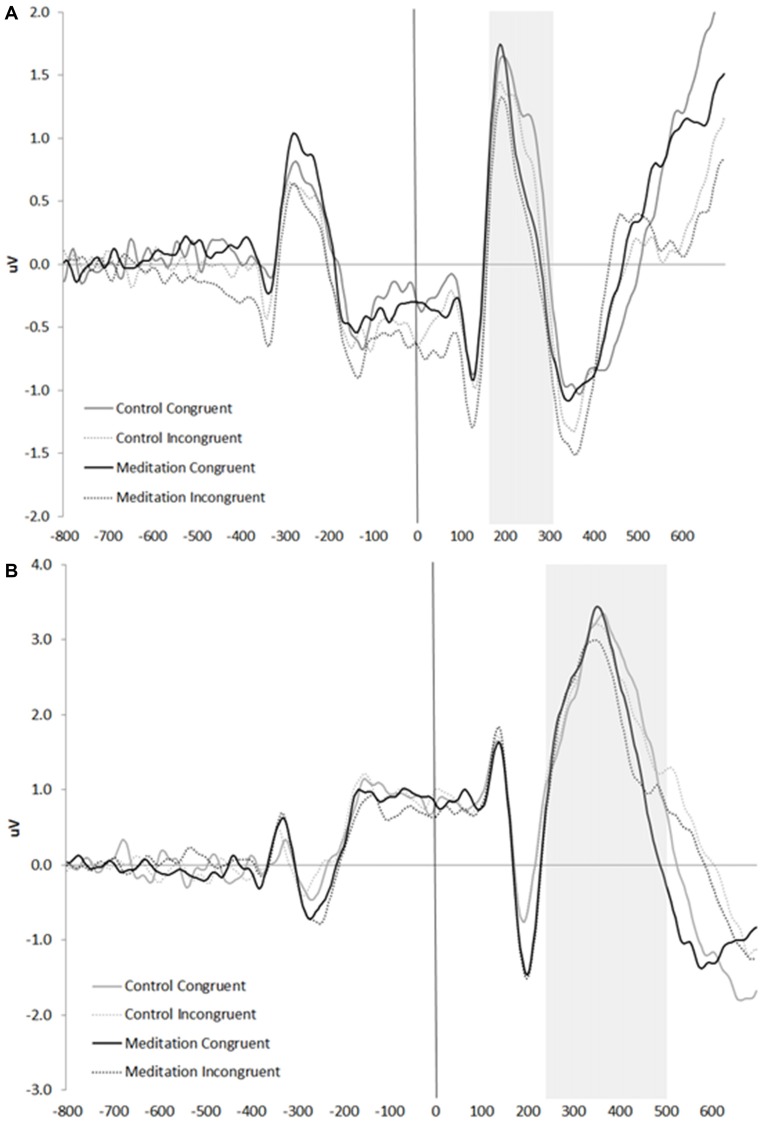
Grand averaged waveforms at (A) Fz and (B) Pz. The solid vertical line indicates the onset of the Flanker stimulus; the gray boxes indicate the time window analyzed for the (A) N2 and (B) P3b.